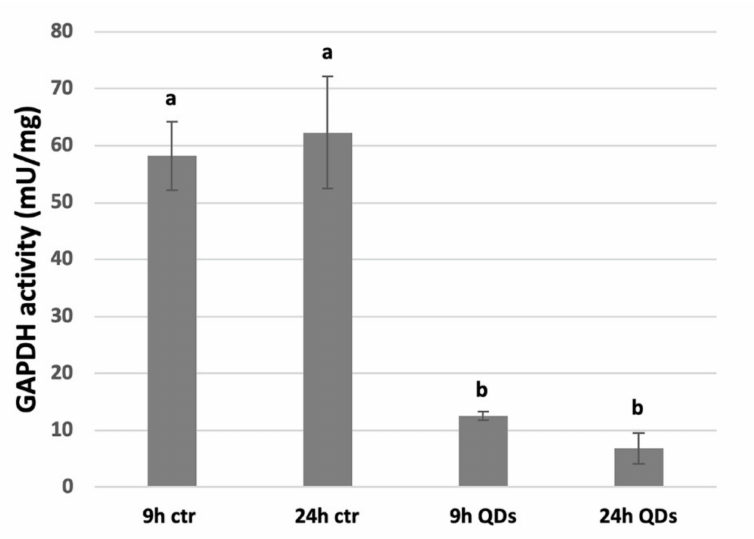
Figure 9. GAPDH (glyceraldehyde-3-phosphate dehydrogenase) activity. ANOVA average of three replicates followed by Bonferroni post hoc test. Di ff erent letters indicate a statistic di ff erence with p <